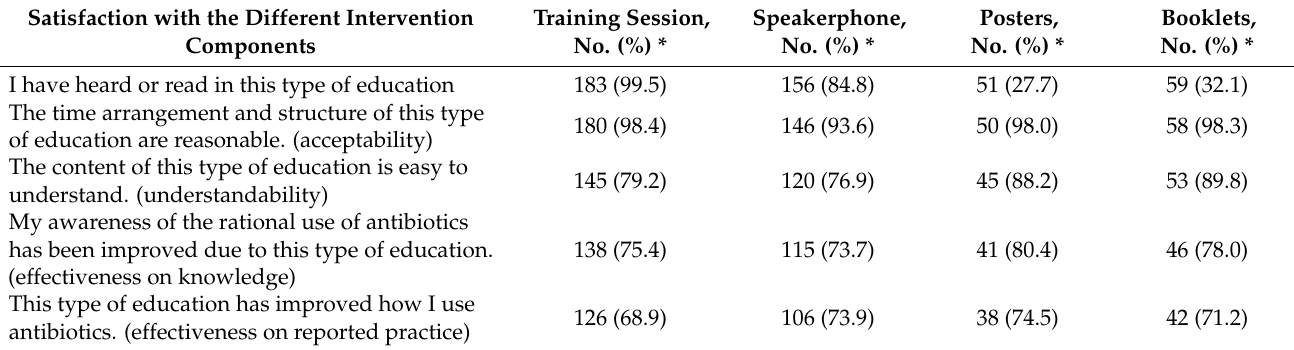
Table 5. Process evaluation on the performance of four types of